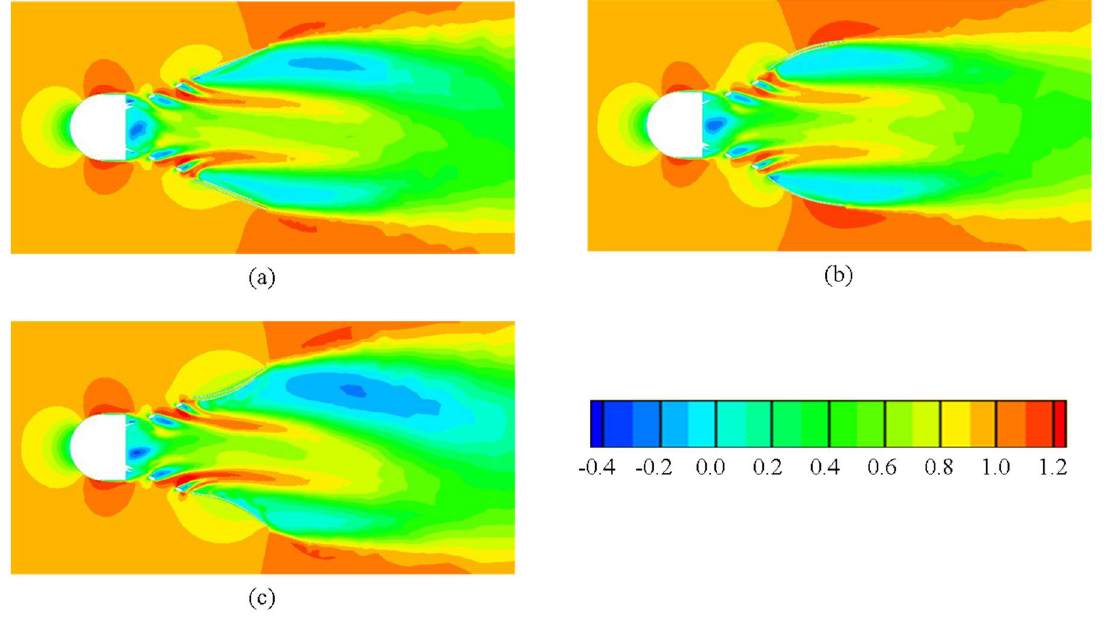
Figure 5. Contour map of the velocity component U/U ∞ . ( a ) Standard, h = 0.0 mm; ( b ) Positive